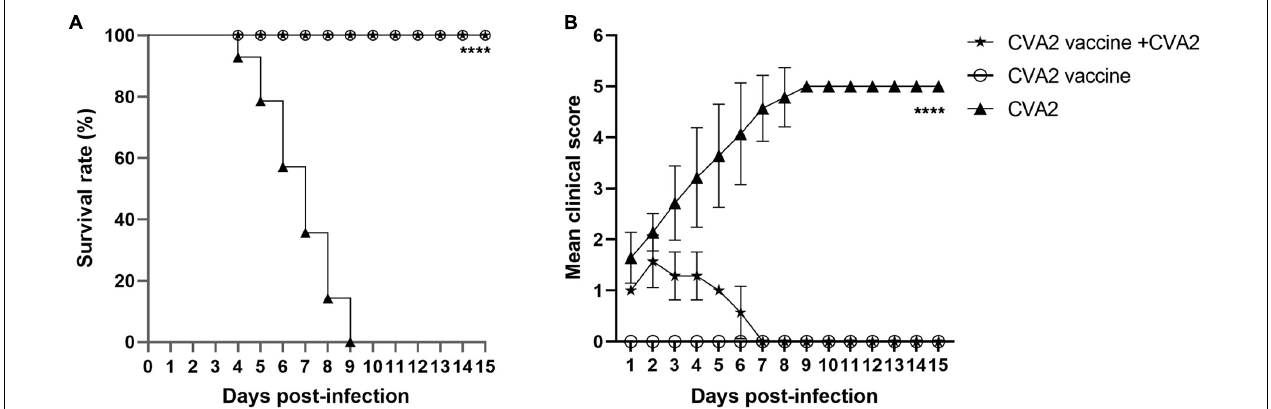
FIGURE 8 | The active immunization with inactivated vaccine protects pups against viral challenge. The inoculated mice were monitored daily for survival rates (A) and clinical scores (B) for 15 days. The log-rank (Mantel-Cox) test was used to compare the survival curve between vaccine group and the negative control group. **** P <